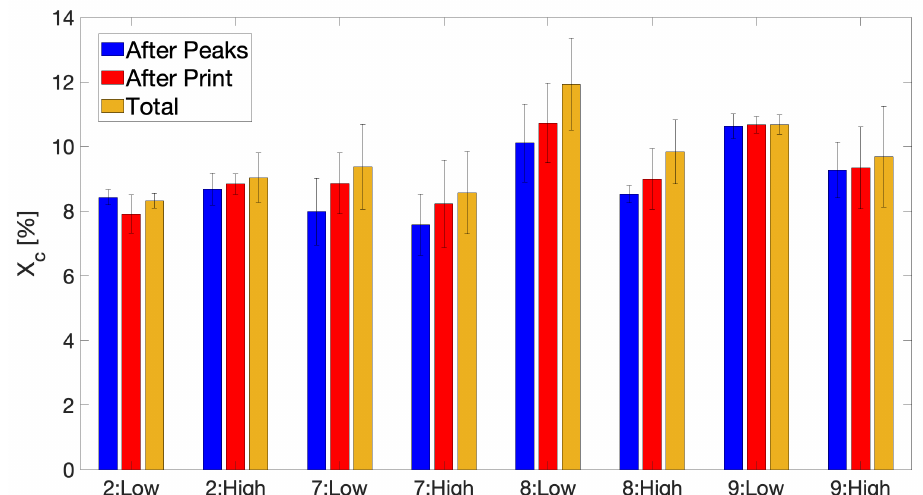
Figure 7. The comparison of the degrees of crystallinity X c after each segment of the thermal history as obtained by FSC for conditions 2, 7, 8 and 9, all printed at low T build plate of 40 °C. ‘Low’ and ‘High’ refer to layer 10 and 40,